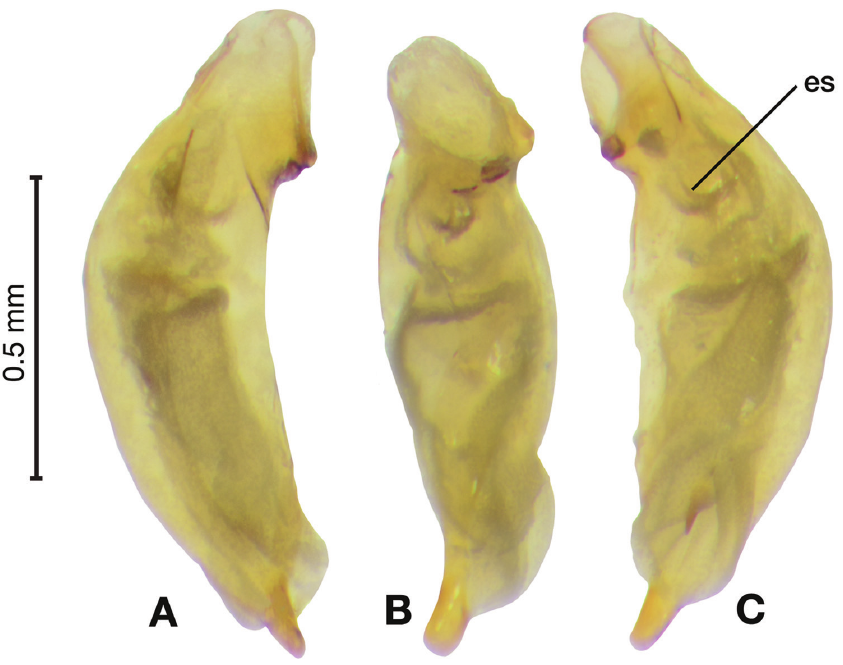
Figure 40. Digital images of male genitalia of C. ( Coptoderina ) eluta Andrewes. A right lateral aspect B ventral aspect C left lateral